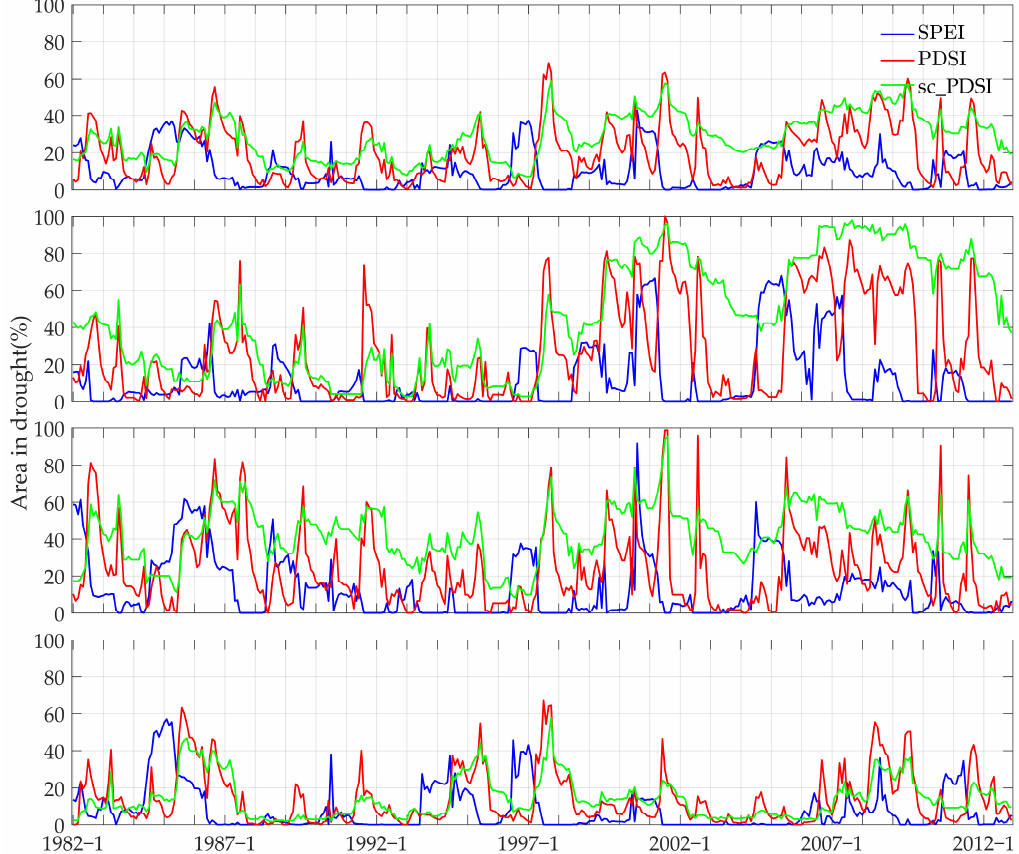
Figure 5. Time series of percentage regional averaged areas in drought of the whole dryland (%) based on SPEI-01, PDSI, sc_PDSI during 1982–2012. The drought areas are defined locally when SPEI-01 (Blue Lines) is below − 1.5; PDSI (Red Lines), sc_PDSI (Green Lines) is below − 2. ( a ) The whole study area; ( b ) The semi-arid area; ( c ) The east-arid area; ( d ) The west-arid area.